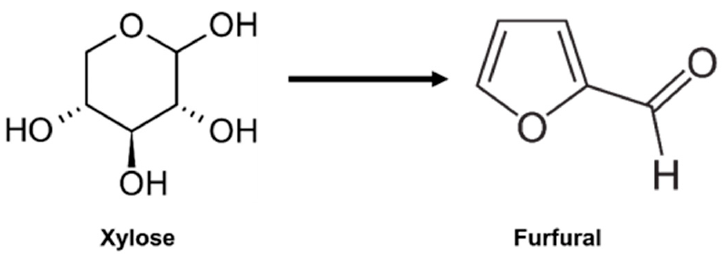
Figure 19. Conversion of xylose into